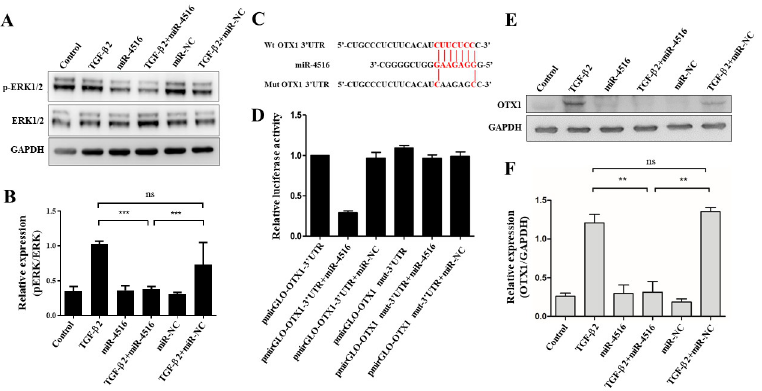
Fig 5. MiR-4516 exerted effects on the EMT through OTX1/ERK signaling pathway. (A) Representative images and quantification of immunostained phosphorylated ERK and total ERK in the TGF- β 2-treated ARPE-19 cells